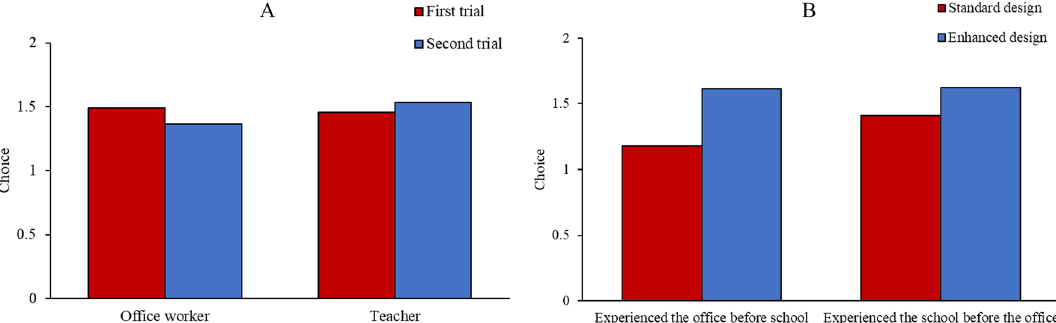
Figure 5. Participants’ choices among run, hide, and fight. ( A ): the effect of building × order × occupation interaction. ( B ): the effect of design × order interaction.